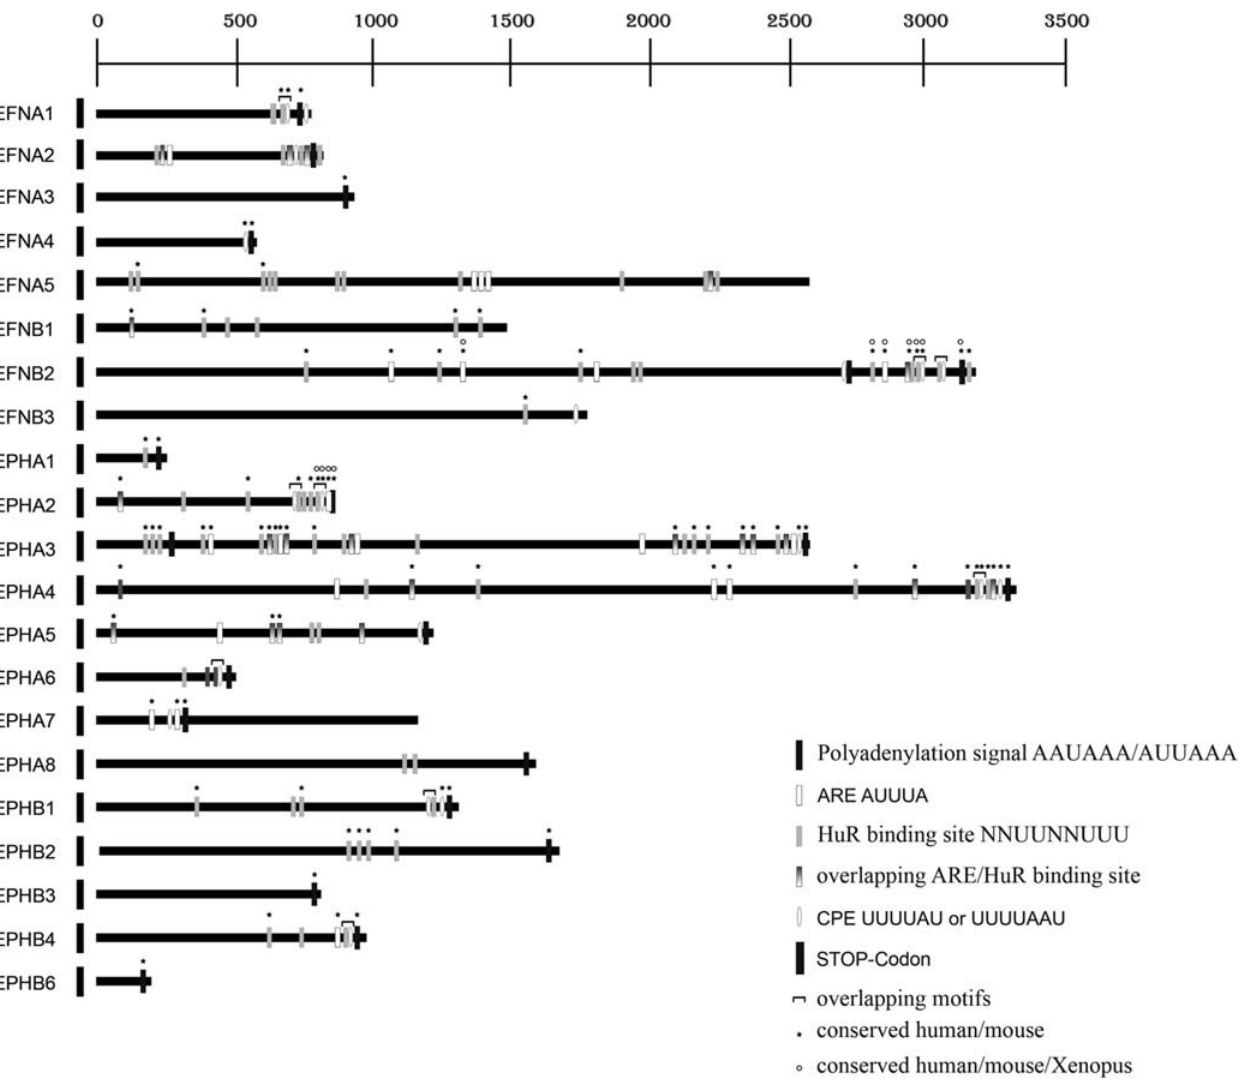
Figure 1. The 3’untranslated regions of Eph receptors and ephrin ligands. Scheme of the 3’UTRs of Eph/ephrins. Putative cis -acting sequence motifs are highlighted in different colors, conservation between human/mouse, human/mouse/Xenopus is shown by asterisks/open circles.